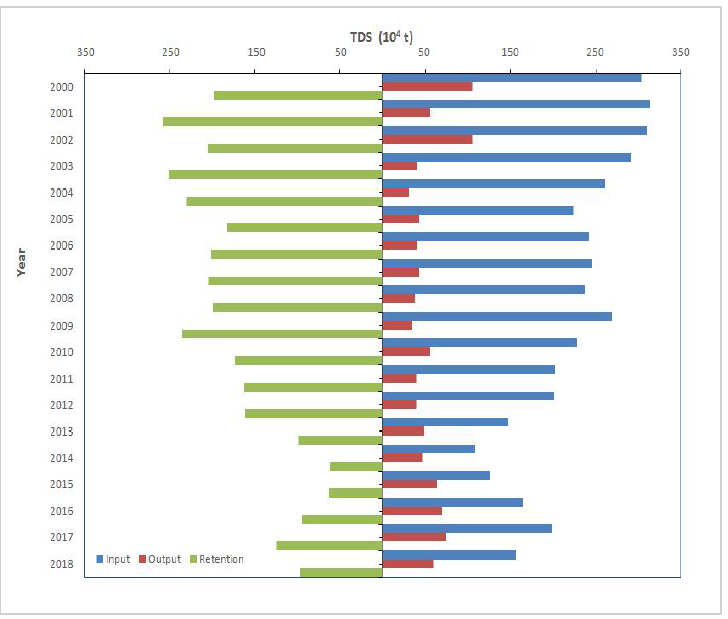
Figure 3. Butterfly chart of TDS amount entering the lake (Input), TDS amount discharged from the lake (Output), and TDS amount retained (Retention) in the lake in